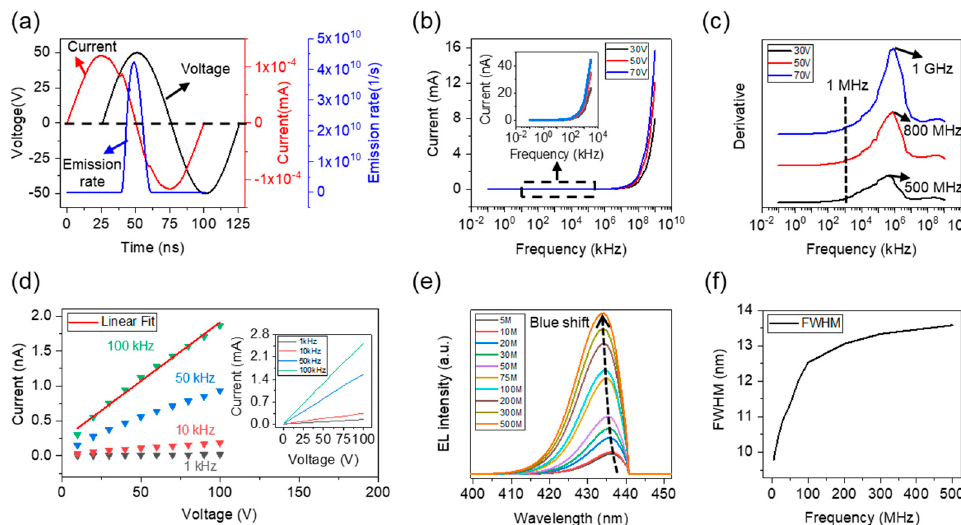
Figure 3. Electrical and optical properties of the nano-LED operating in the NEC&NCI mode. ( a ) Waveform of the applied sinusoidal voltage, measured current, and emission rate of the device in one AC voltage cycle. ( b ) Relationship between the peak current and frequency at different voltage amplitudes. ( c ) Derivative of the peak current. ( d ) Peak current-peak voltage curves at different frequencies. Inset: experimental i - v curves. ( e ) EL spectra at different frequencies. ( f ) Relationship between FWHM and the frequency.